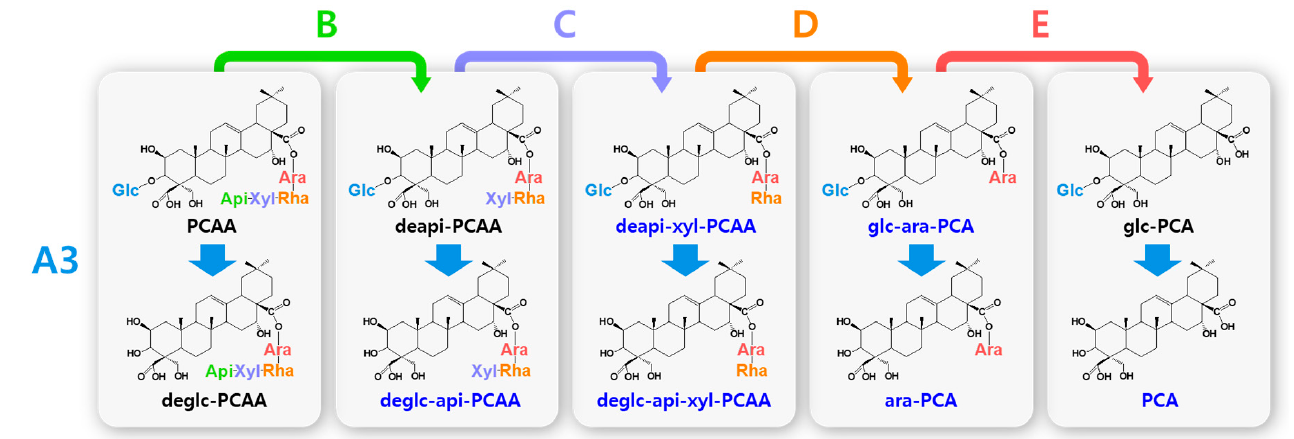
Figure 4. Hydrolytic pathways of the PCA-type platycosides by glycosidases. The hydrolytic pathways of the glucoside residue linked to C-3 by β - D -glucosidase are assigned as A3. The hydrolytic pathways of the four residues, including apioside, xyloside, rhamnoside, and arabinoside, linked to C-28 in PDN-type platycosides by β - D -apiosidase, β - D -xylosidase, α - L -rhamnosidase, and α - L -arabinosidase are assigned as B, C, D, and E, respectively. Blue indicates unreported platycosides, which can be suggested by the reported glycosidases. Red indicates unreported platycosides, which cannot be suggested by the reported glycosidases.